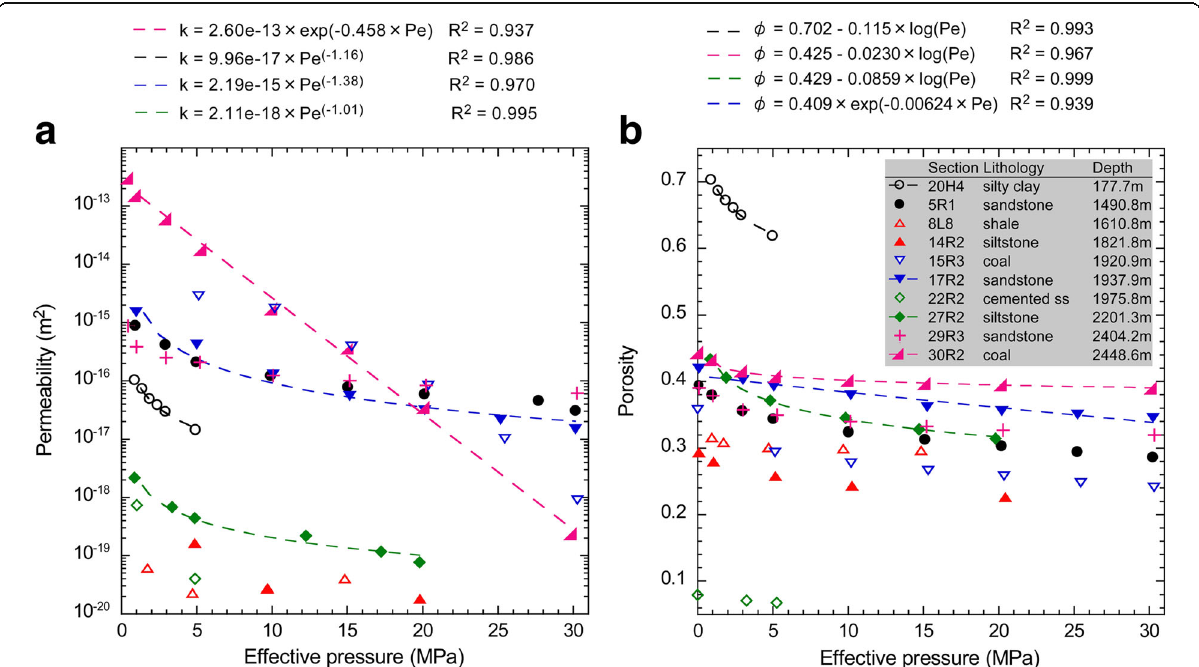
Fig. 4 Effective pressure dependence of a permeability and b porosity of core samples at Site C0020. The fits estimated by the least squares method and errors are also shown. Pe: effective pressure (MPa), k : permeability (m 2 ), Φ : porosity, and R 2 : coefficient of determination for least squares